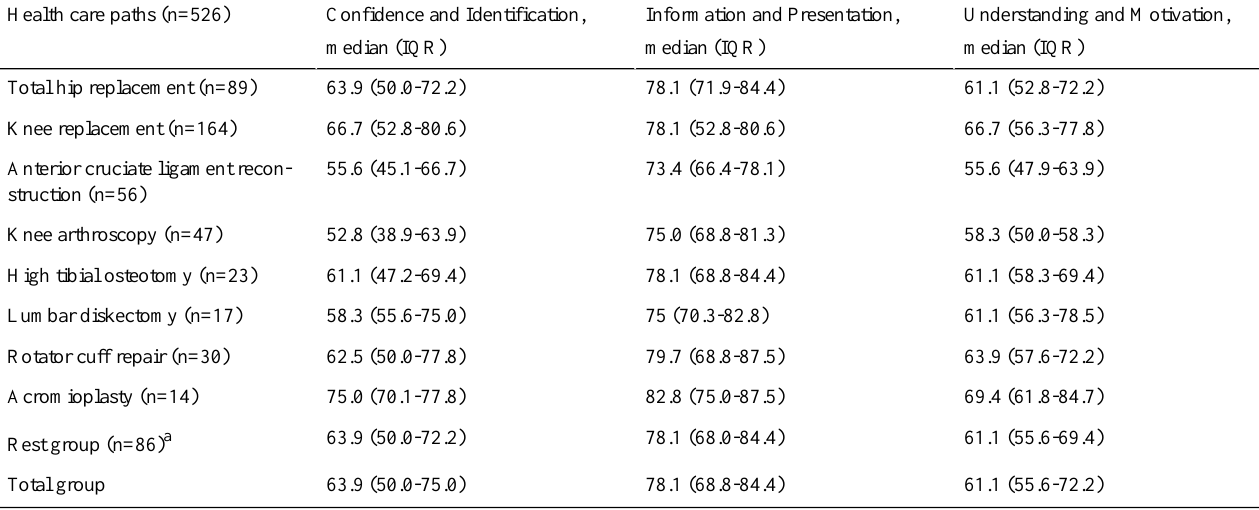
Table 3. Attitude toward the app (eHealth Impact Questionnaire, 0 to